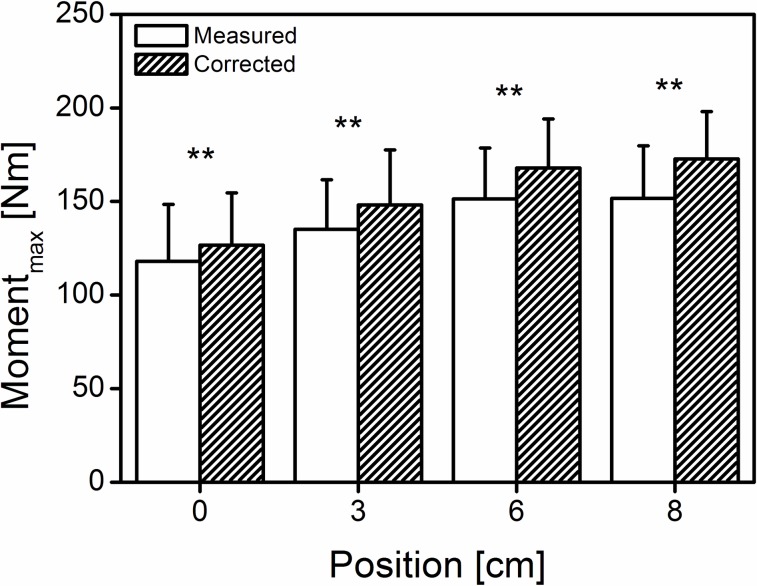
Mean (±SD) of the measured and corrected maximal exerted joint moment.Open box: measured joint moment, shaded box: corrected joint moment at the different subject positions (0 cm = neutral, 3-6-8 cm; n = 42). **significant differences (p < 0.01) between the measured and corrected maximal joint moment.